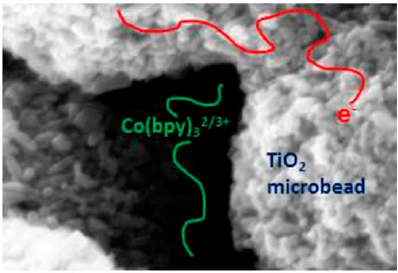
Figure 12. Diffusion in mesoporous mircobeads. Reprinted with permission from [95]. Copyright 2018, American Chemical Society.